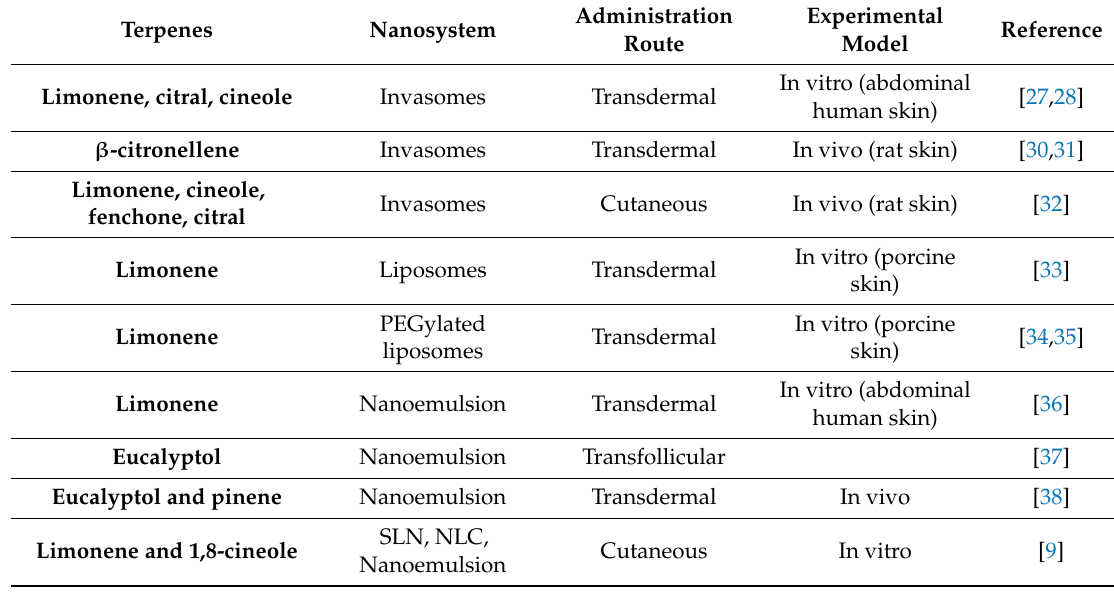
Table 1. Terpenes as skin permeation enhancers encapsulated in nanostructured lipid systems.